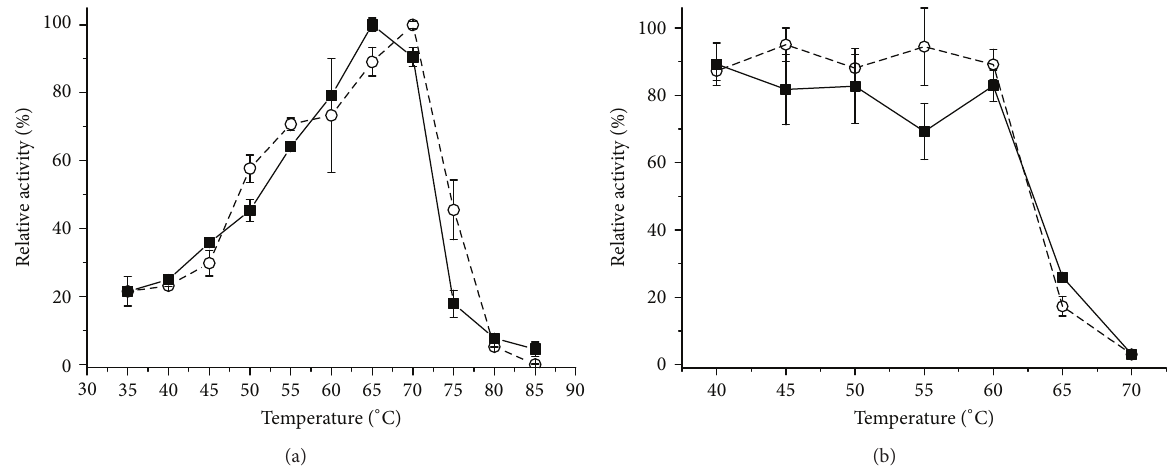
Figure 7: Effect of temperature on the activity of 𝛽 -glucosidase of the crude extract from M . heterothallica F.2.1.4. at pH 5.0. (a) ( ◼ ) SSCWB and ( I ) SmCP. Temperature effect on the stability of the 𝛽 -glucosidases. (b) ( ◼ ) SSCWB and ( I )